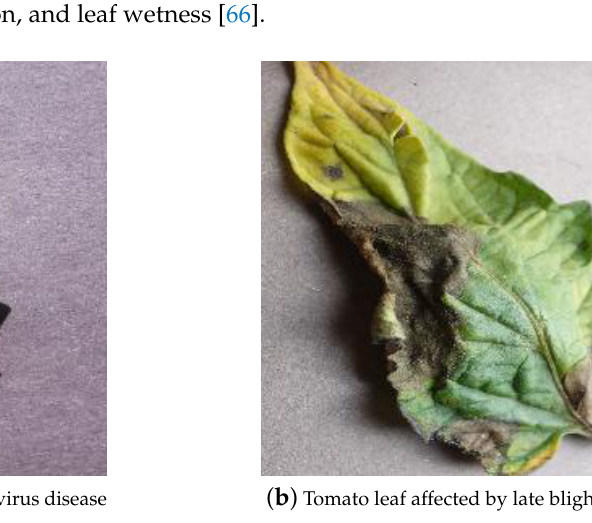
Figure 3. Examples of tomato leaves affected by diseases taken from the PlantVillage data-set [61].